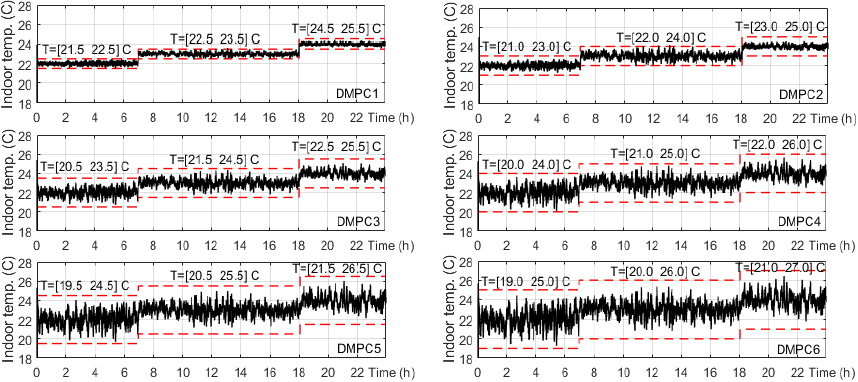
Figure 15. Indoor temperature deviation of the DMPCs for IACs control of case 3.